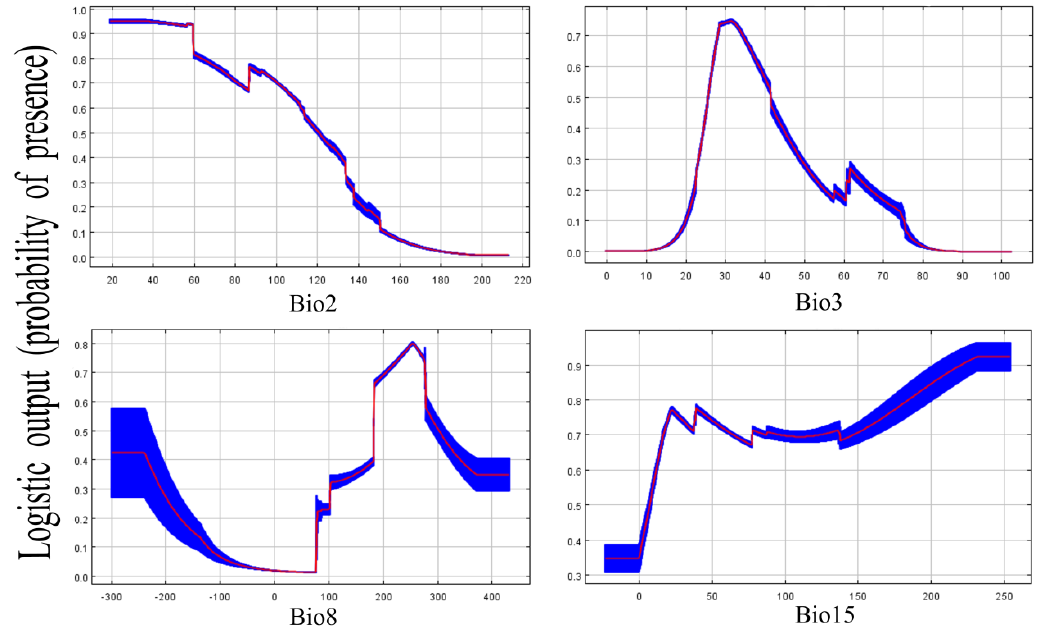
Figure 3. Response curves showing the relationships between the probability of presence of P. pentagona and four bioclimatic variables. Values shown are average over 10 replicate runs: blue margins show ± SD calculated over 10 replicates.